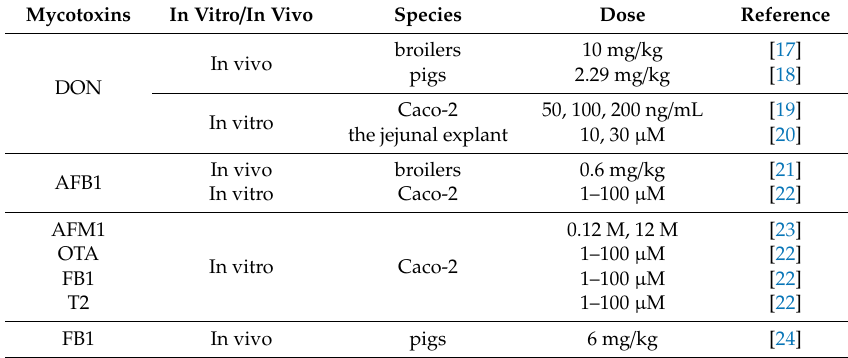
Table 1. In vivo and in vitro studies on the e ff ects of di ff erent mycotoxins on intestinal mucosal mechanical barriers in di ff erent